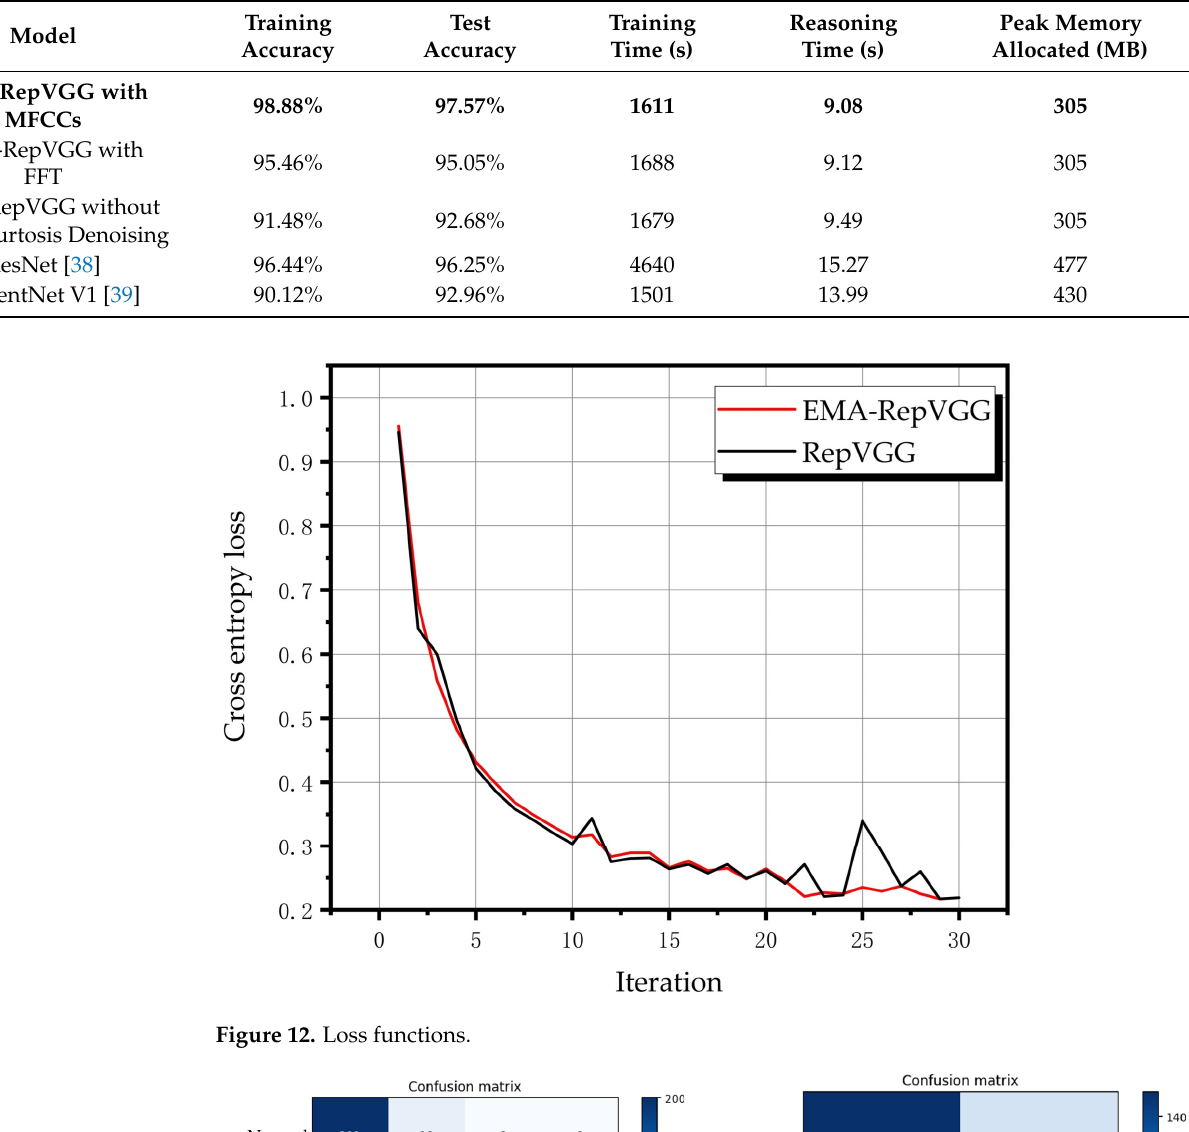
Table 7. Diagnosis accuracy and reasoning time.